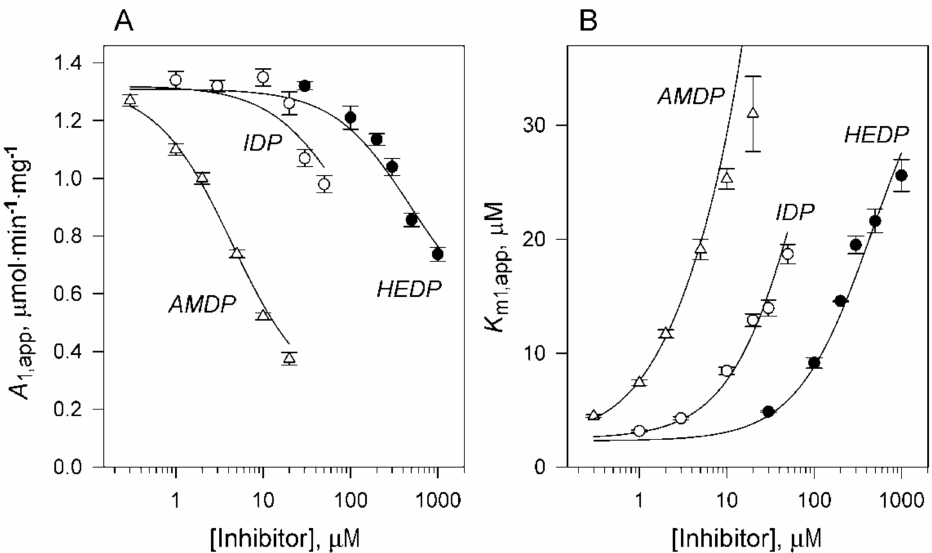
Figure 4. Secondary dependencies of the parameters in Scheme 1 ( A ), maximal activities; ( B ), K m values) on the inhibitor concentration, as calculated from the data in Figure 3. The lines were calculated using Equation (2a,c) with the parameter values found in Table